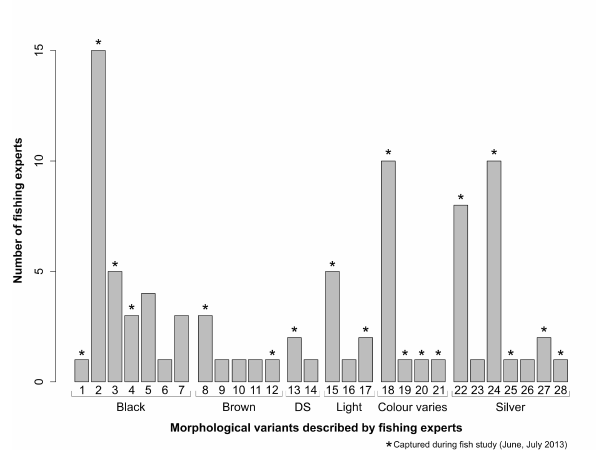
get big” (Informant 2). Even descriptions of black forms varied from very black with spots that are hard to see, to black with identifiable spots and yellow-tipped fins, to maasimekw - namekush (brook trout-like), where the caudal fin was not as deeply forked and both the texture of the scales and flesh color (pink) were different from typical lake trout. Fig. 3 . Frequency of discernible lake trout morphological variants described by Cree First Nation fishing experts grouped by color (DS = dark silver).